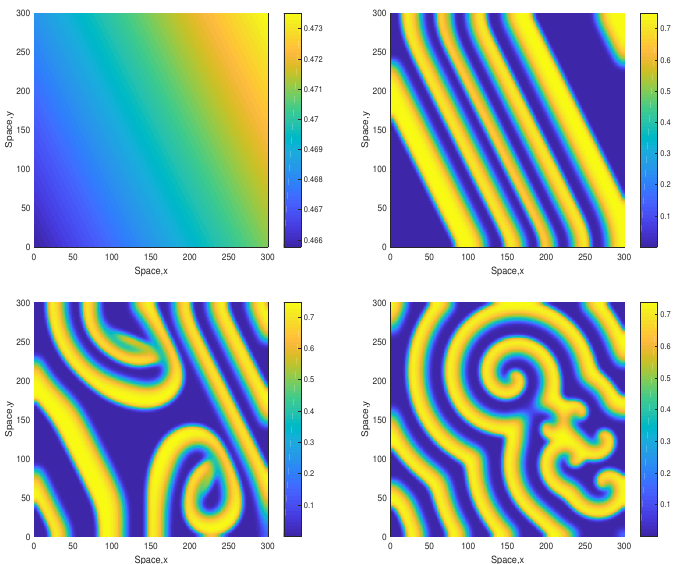
Figure 3. Spatial distribution of the oxygen concentration obtained for A = 2.3 and shown for t = 1, t = 200, t = 800 and t = 2000 (left to right, top to bottom). Other parameters are the same as above. The initial conditions are given by Equations (10)–(12) with c 0 = 0.4696, u 0 = 0.3775 and v 0 = 0.1501.